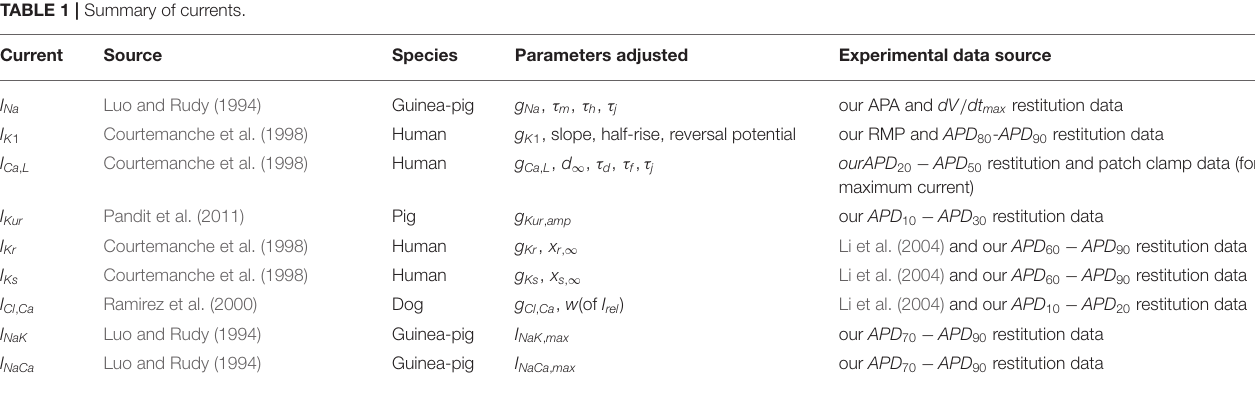
TABLE 1 | Summary of